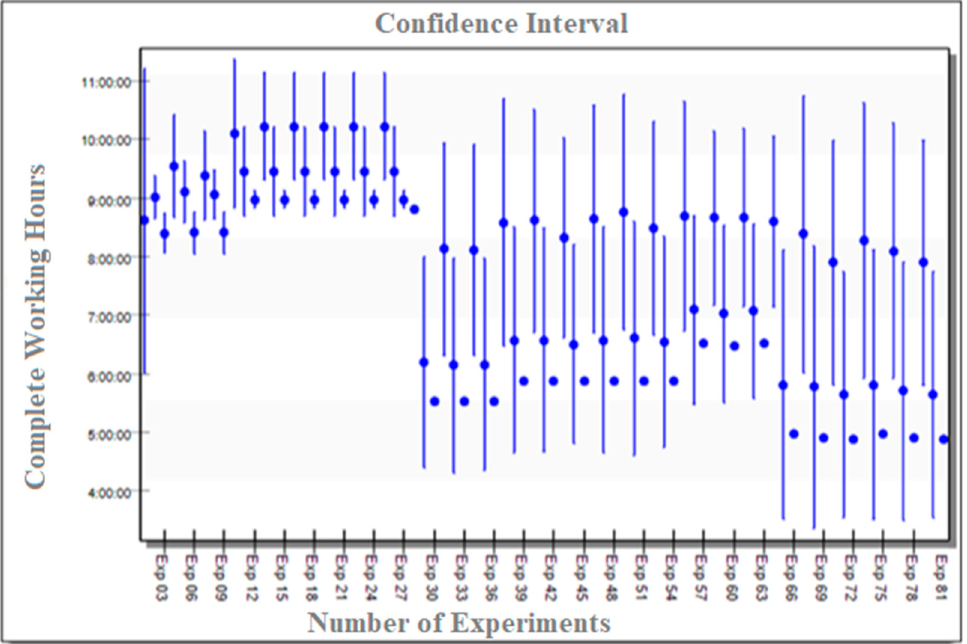
Figure 18. Completion time of 100 h under the individual resource pool.